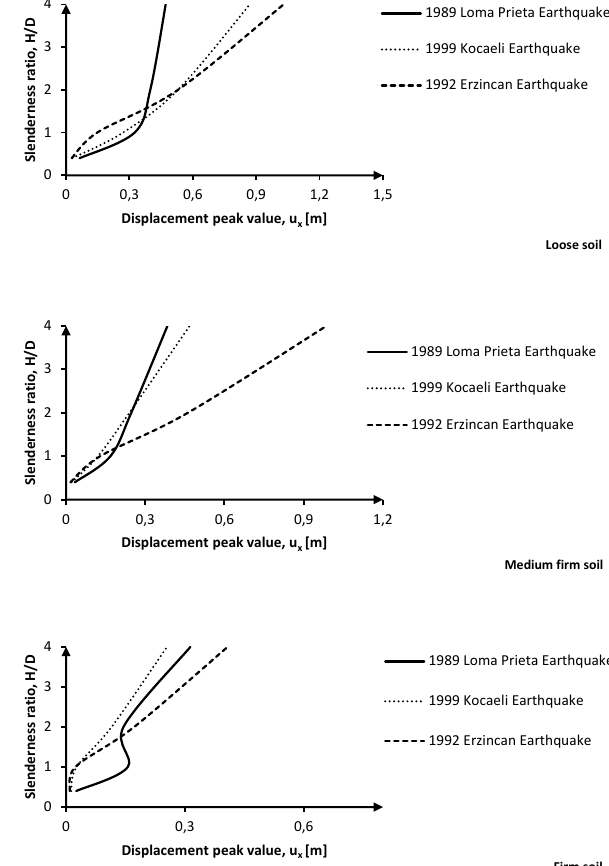
Fig. 8. The variation of peak lateral displacements for top floor with Fig 8. The variation of peak lateral displacements for top floor with respect to slenderness respect to slenderness ratio ( H/D ) under different seismic ratio (H/D) under different seismic inputs.